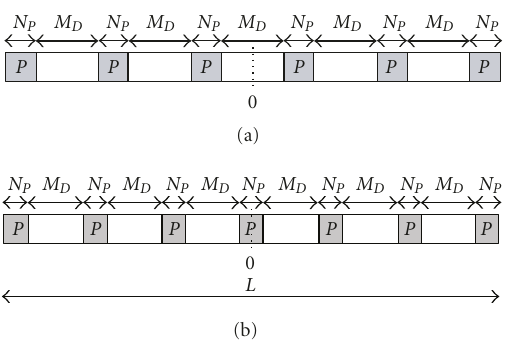
Figure 12: Generic symmetric burst format.